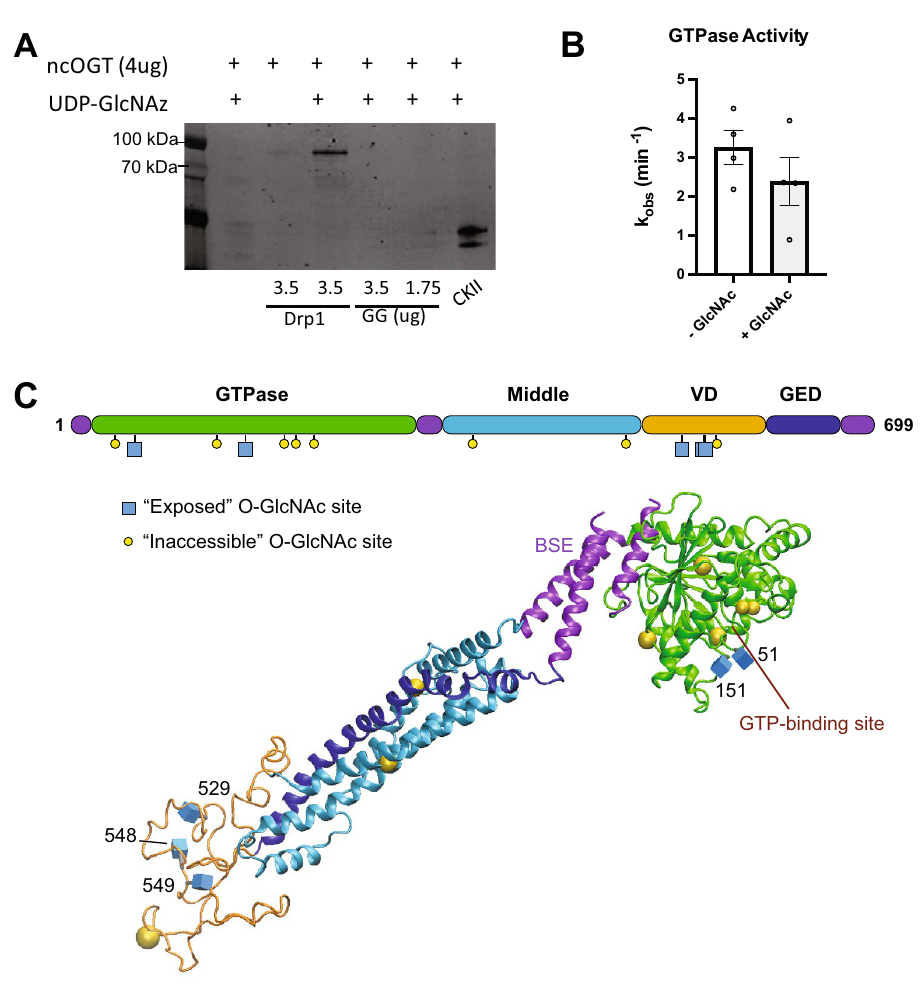
Figure 5. In vitro validation and Prediction of Drp1 O -GlcNAcylation Sites. ( A ) In vitro O -GlcNAcylation of recombinant Drp1 and Drp1 GTPase-GED (GG, GTPase domain, green, & BSE, magenta purple) with recombinant OGT was observed. ( B ) GTPase activity rates were measured using a continuous GTPase assay with full-length Drp1 that had been incubated with OGT with or without UDP-GlcNAc. ( C ) Drp1 protein domain schematic and a 3D homology model highlights predicted O -GlcNAc modifications (blue cubes denote solvent accessible predicted residues and yellow spheres denote solvent inaccessible predicted residues). The complete list of predicted sites is available in Supplementary Table